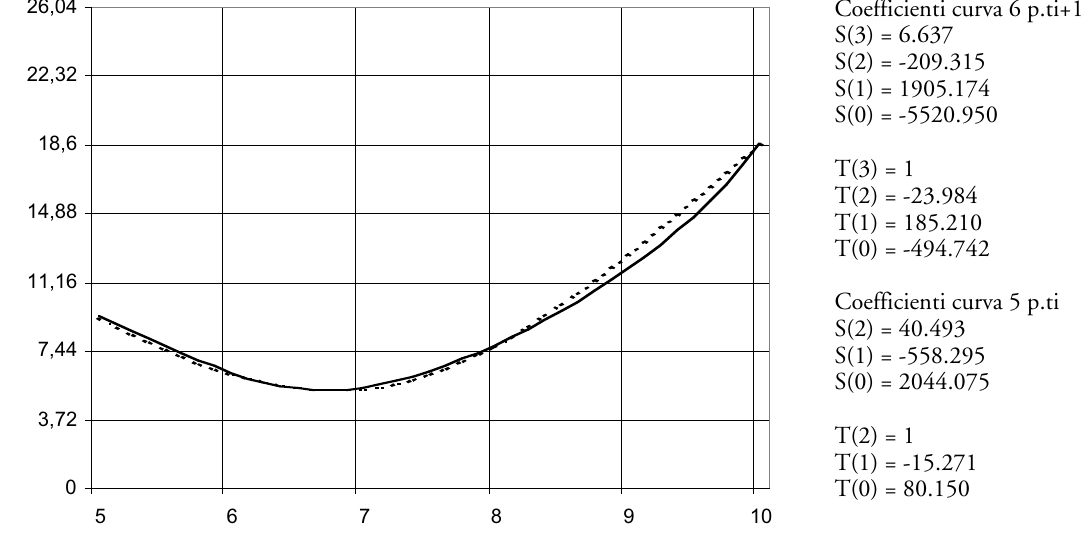
Figura 3 – Rilevazione di CO